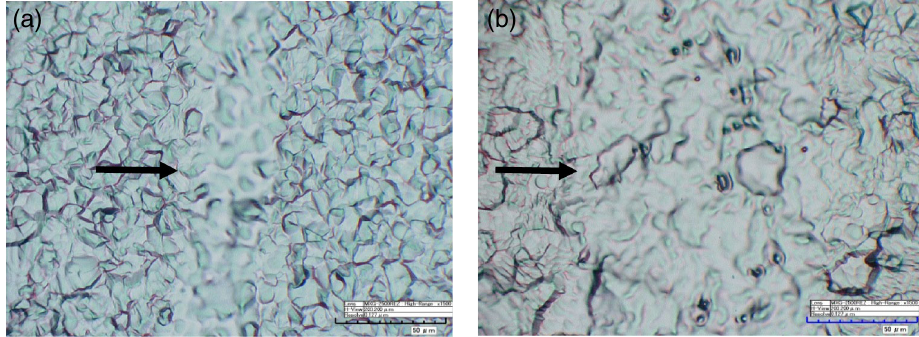
FIG. 4. Optical images of niobium surfaces after laser treatment: (a) 0 . 90 J = cm 2 , 34 pulses overlapped, 1 . 8 μ m pulse displacement, scanning speed 3 . 5 cm = s. (b) 2 . 27 J = cm 2 , 23 pulses overlapped, 3 . 0 μ m pulse displacement, scanning speed 5 . 6 cm = s. The arrows indicate the laser